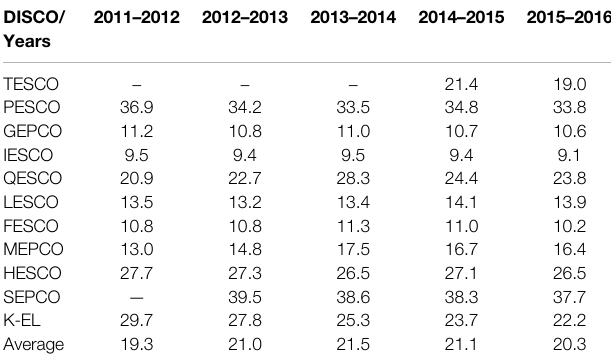
TABLE 4 | Display transmission and dispatch (T&D) failures in percentage GWh of overall power generated in Pakistan (source